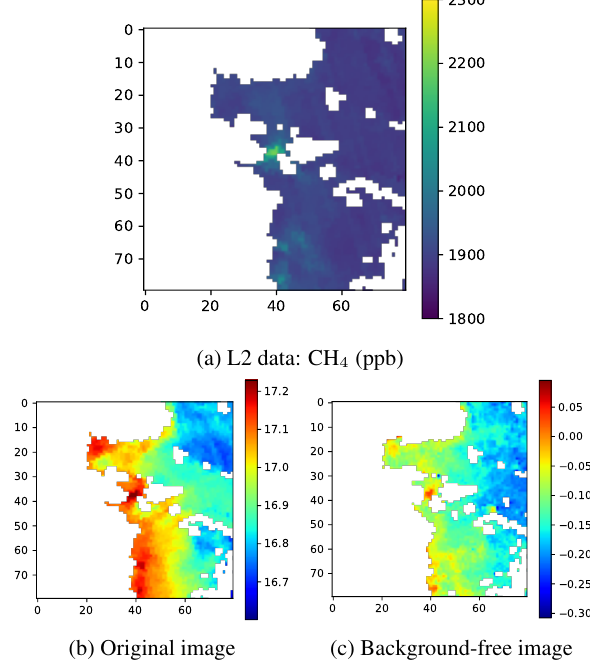
Figure 4. In the image (a) we see a methane plume in green. Images (b) and (c) show the channel at wavelength 2370.448nm before and after background substraction